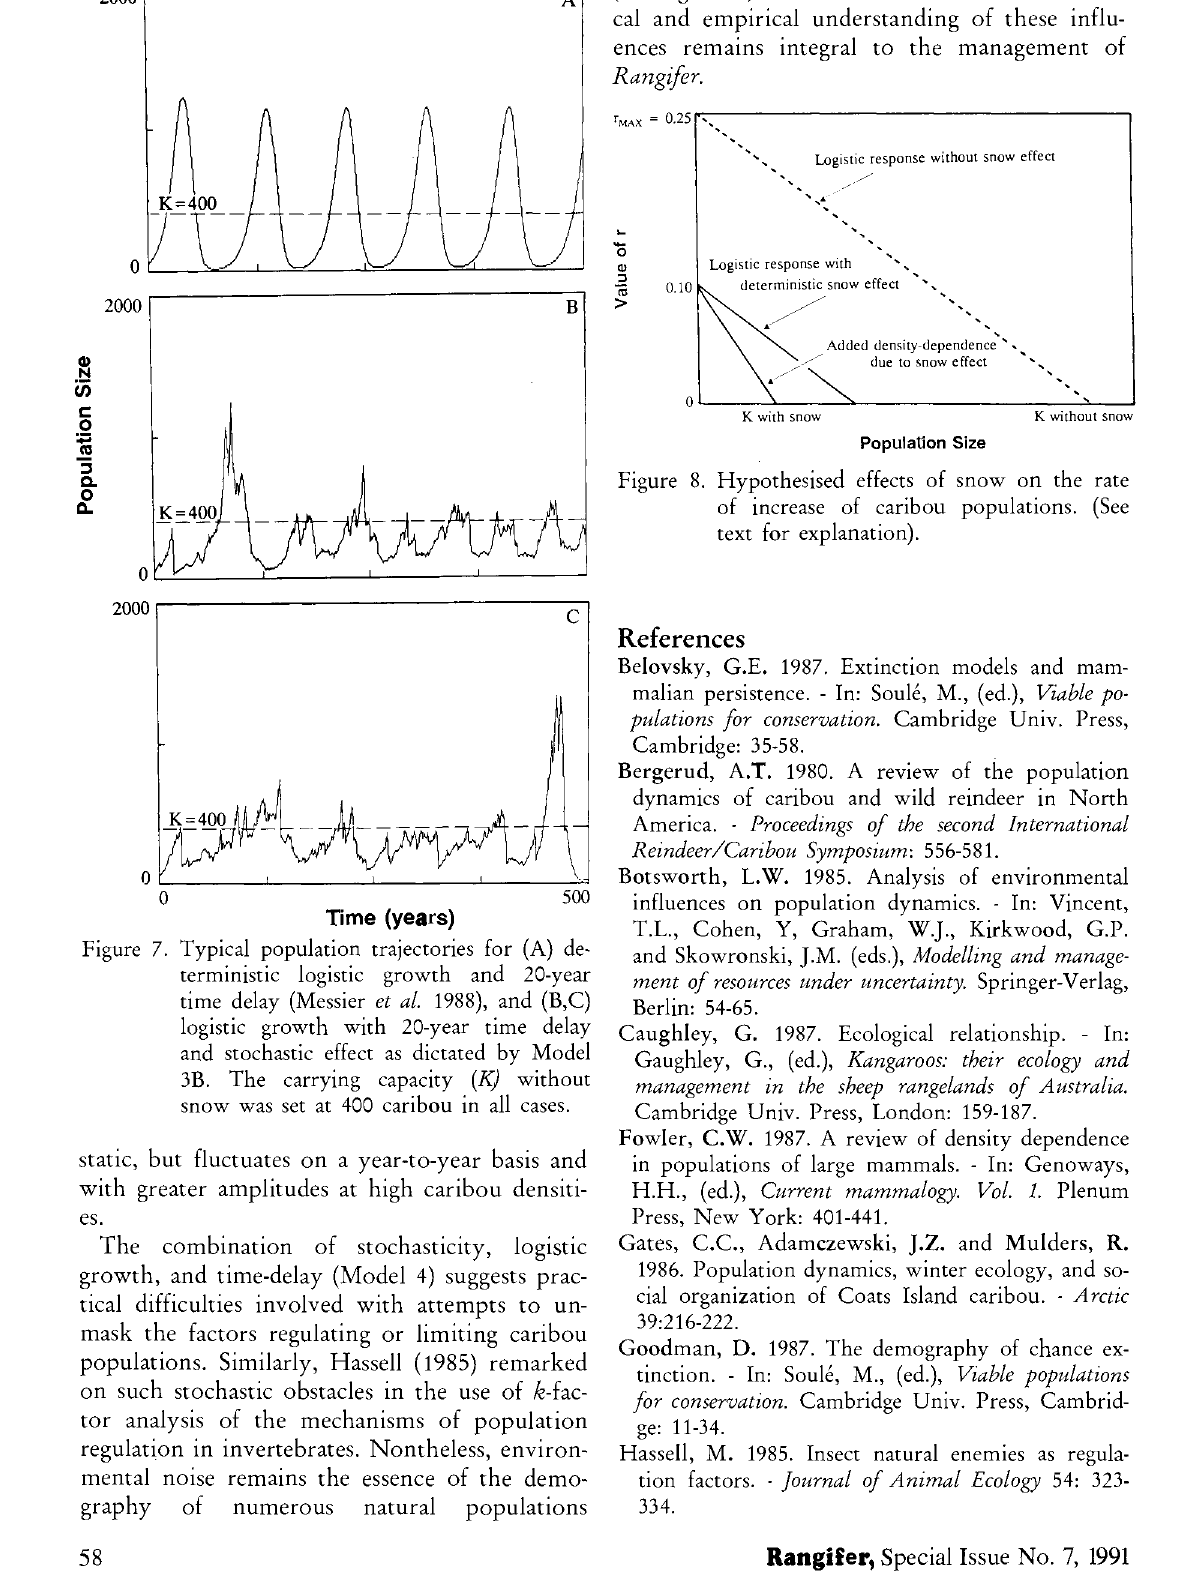
Figure 7. Typical population trajectories for (A) de terministic logistic growth and 20-year time delay (Messier et al. 1988), and (B,C) logistic growth with 20-year time delay and stochastic effect as dictated by Model 3B. The carrying capacity (K) without snow was set at 400 caribou in all cases.